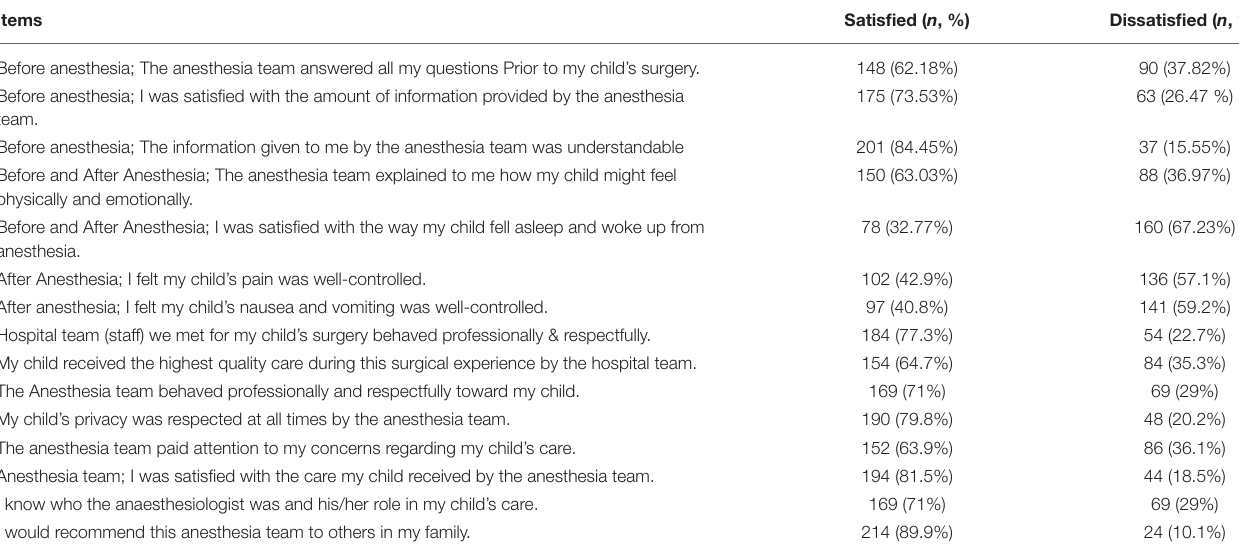
TABLE 3 | Level of parental satisfaction toward their child’s anesthesia service, N = 238, 2021.